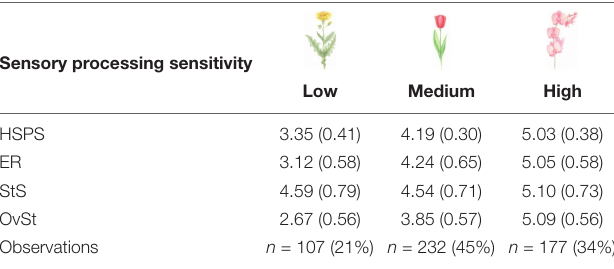
TABLE 3 | Descriptive statistics M(SD) and number of observations for HSPS in the three clusters of sensitivity.